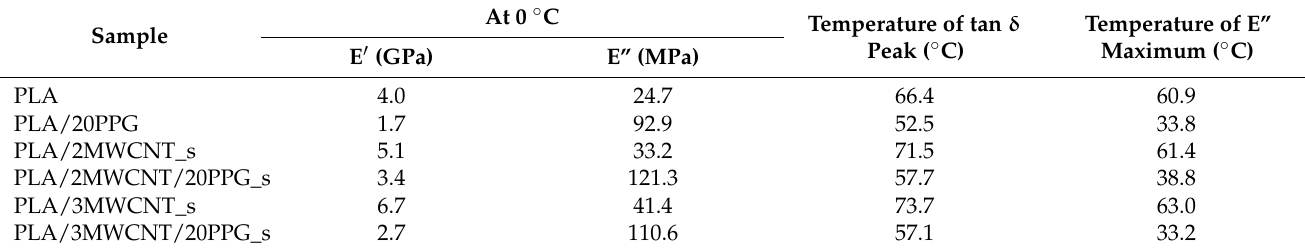
Table 6. E (cid:48) , E”, and tan δ peak for neat PLA and composites.